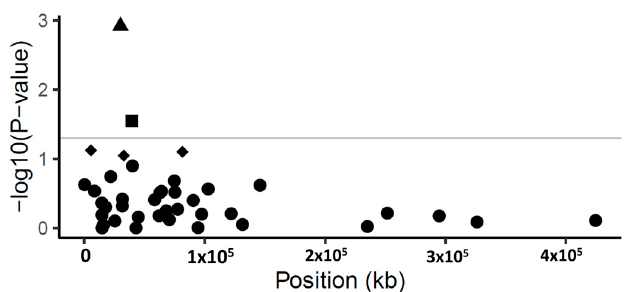
Figure 1. Manhattan plot of p -values ( − log10 scale) for SNP associations to disease severity in common ash. The p -values are plotted against position of the SNP in the sca ff olds. Grey line indicates the threshold value ( − log10 of p -value of 1.3) for declaring a significant association. Triangle symbol indicates the statistically significant SNP ( p -value < 0.001, FDR = 0.04) in sca ff old 5992; square symbols show marginally significant SNPs ( p -value < 0.05). Diamond-shaped symbol indicates non-significant SNPs ( p -value > 0.05) and circles are the non-associated SNPs with disease